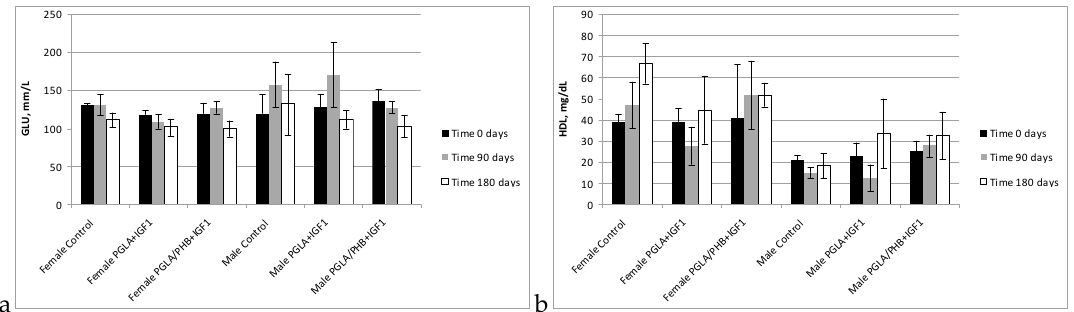
Figure 11. Protein (PROT) ( a ) and total bilirubin (TBIL) ( b ) concentration in blood of rabbits.